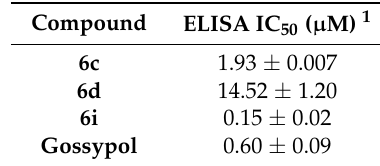
Table 2. Enzyme-linked immunosorbent assay (ELISA) binding activity values (IC 50 ) for selected compounds compared to positive control (-)-gossypol. Results are expressed as triplicate testing mean